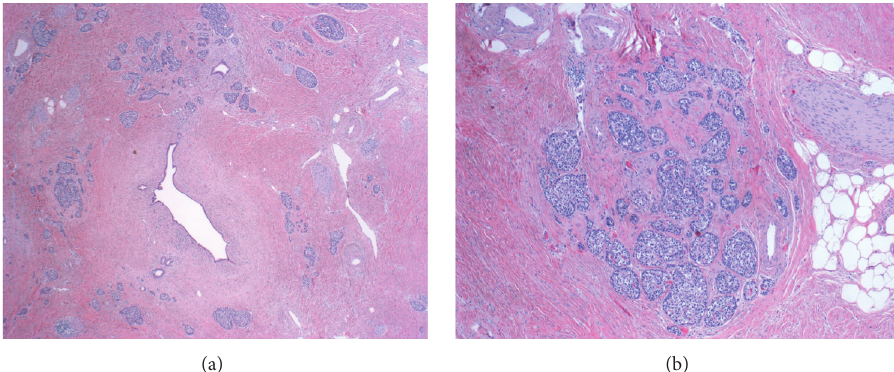
Figure 5: (a) H&E sections demonstrating pancreatic tissue with dense fibrosis, residual ducts, and islet cells. No evidence of residual carcinoma. (b) Cluster of islets of Langerhans within the fibrotic